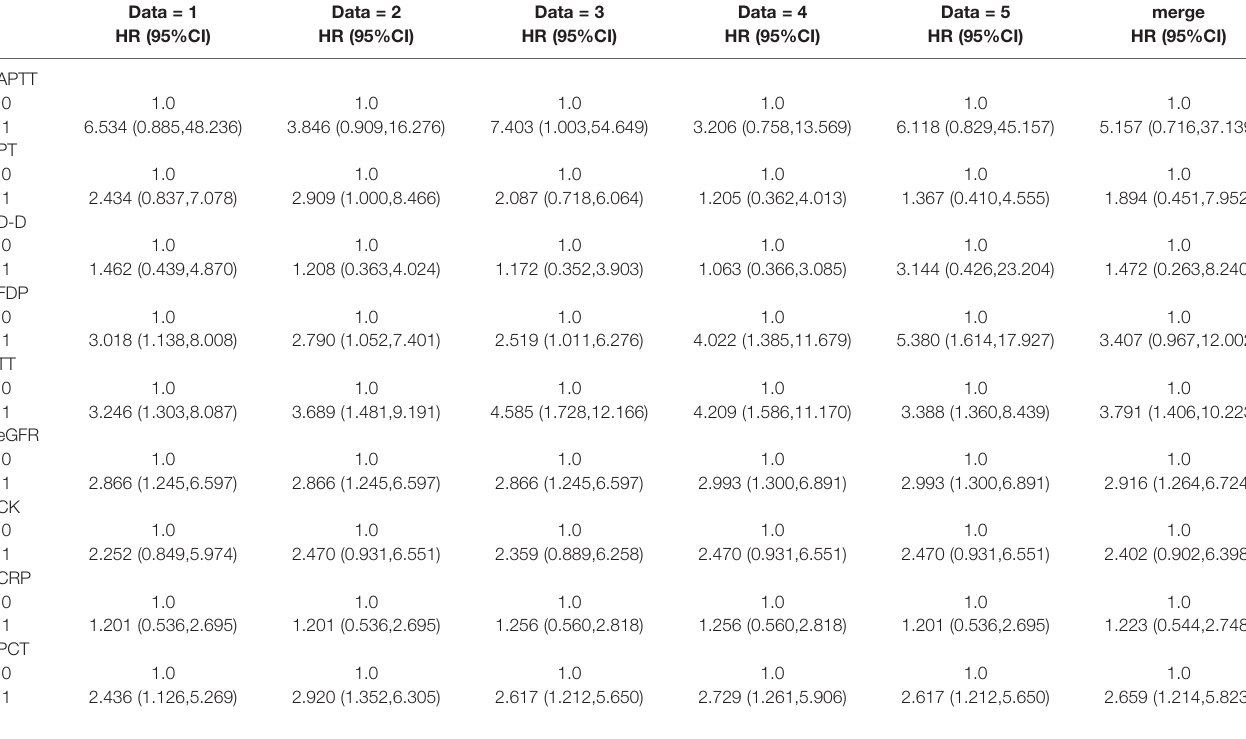
TABLE 9 | Univariate cox regression analysis in fi ve complete data obtained by